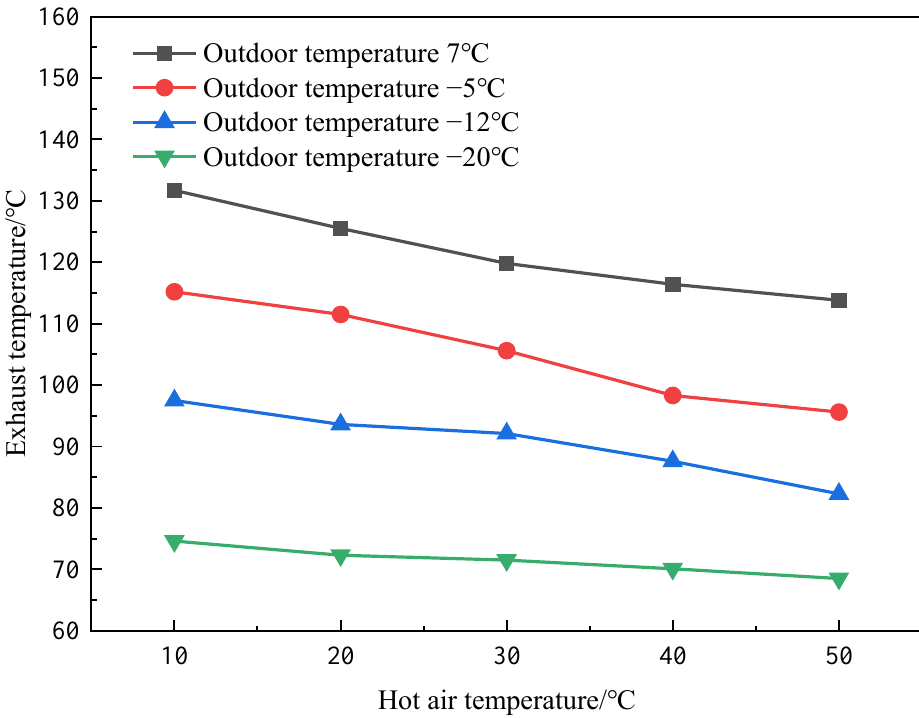
Figure 12. Compressor exhaust temperature changes under different operational conditions. It can be seen from Figures 13 and 14 that the heating capacity and COP of the SC- EVIHP system at different temperatures were improved with hot air. The heating capacity of the SC-EVIHP system improved by 3.9~10.9% and the COP improved by 6.1~11.1%. When the outdoor temperature was −5 °C, the maximum increase in heating capacity was 10.9% compared with the EVI-ASHP system. When the outdoor temperature was −1 2 °C, the COP reached its maximum increase of 11.1%. When the outdoor temperature was −2 0 °C, the COP of the SC-EVIHP system still increased by 10%. This indicates that the SC- EVIHP system is more suitable and energy-saving in cold areas.